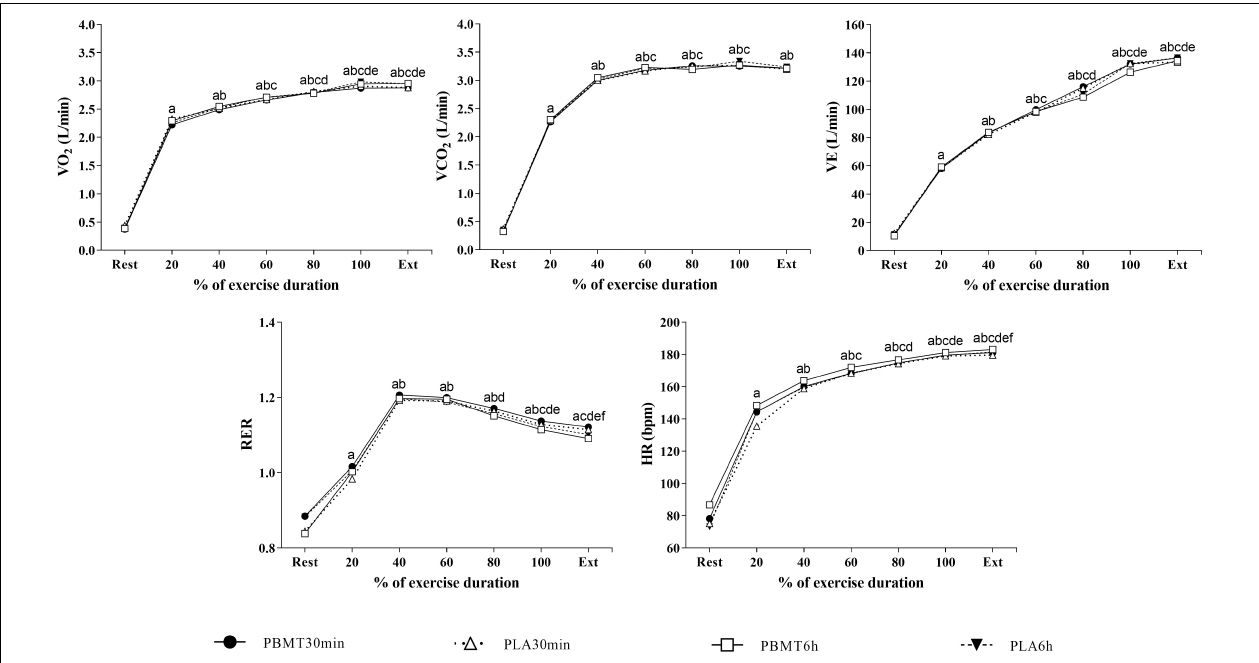
FIGURE 4 | Cardiorespiratory responses measured during severe-intensity cycling until exhaustion. a = main time effect, significant difference from rest; b = main time effect, significant difference from 20% time-window; c = main time effect, significant difference from 40% time-window; d = main time effect, significant difference from 60% time-window; e = main time effect, significant difference from 80% time-window; f = main time effect, significant difference from 100% time-window; Ext, exhaustion; ˙ VO 2 , oxygen uptake; HR, heart rate; ˙ V E , pulmonary ventilation; ˙ VCO 2 , carbon dioxide output; RER, respiratory exhange ratio; PBMT 30 min , photobiomodulation applied 30 min before exercise; PLA 30 min , placebo treatment applied 30 min before exercise; PBMT 6 h , photobiomodulation applied 6 h before exercise; PLA 6 h , placebo treatment applied 6 h before exercise. n = 13. Error bars not included for